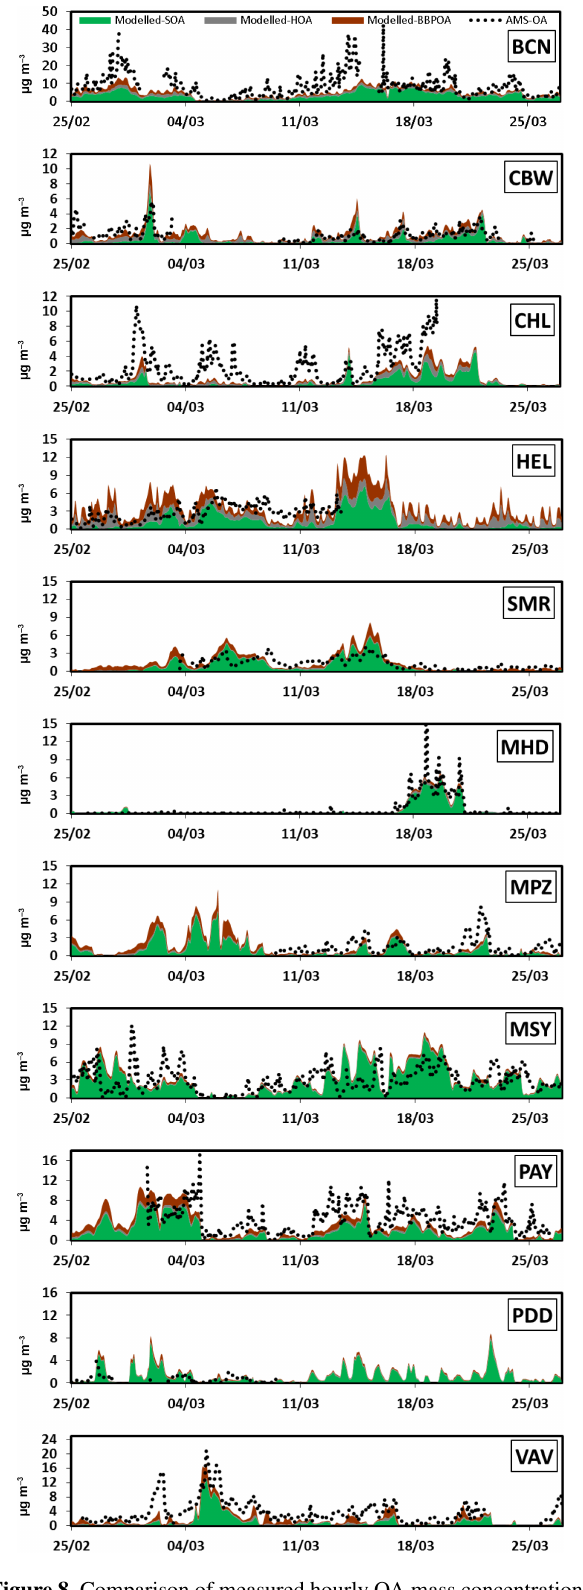
Figure 8. Comparison of measured hourly OA mass concentrations (AMS-OA, dotted line), with modelled components HOA, BBPOA and